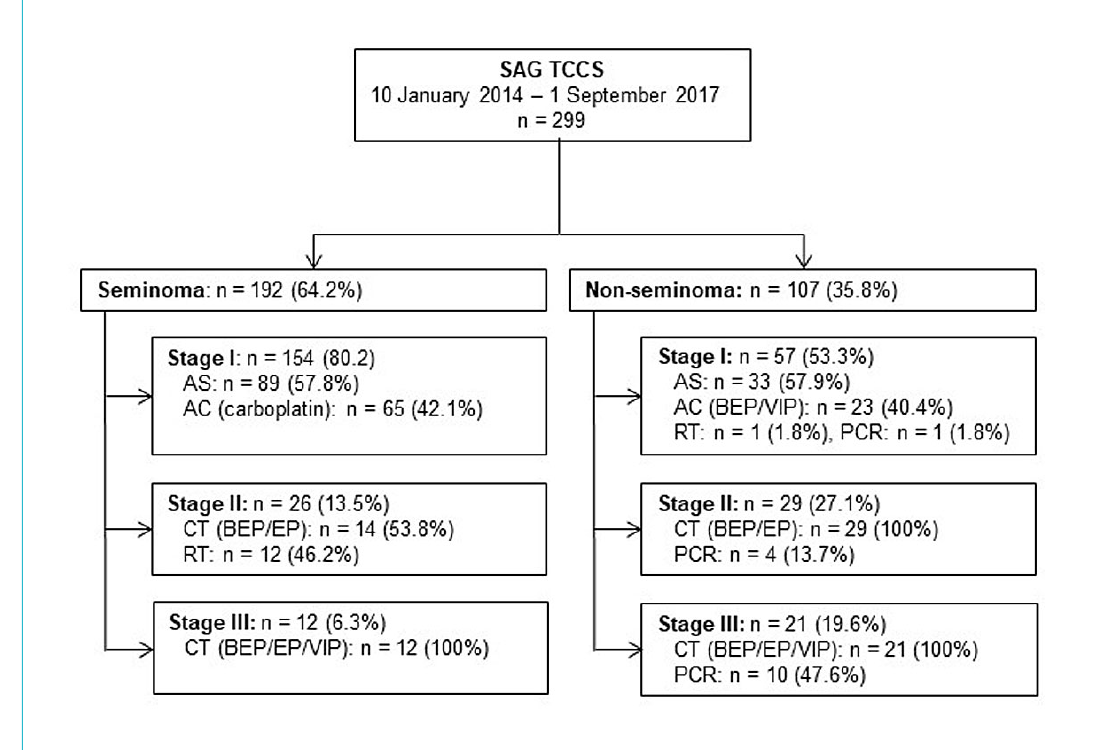
Figure 1: Distribution of GCT patients: AC = adjuvant chemotherapy; AS = active surveillance; BEP = bleomycin, etoposide, cisplatin; CT = curative chemotherapy; EP = etoposide, cisplatin; PCR = postchemotherapy resection; RT = radiotherapy; SAG TCCS = Swiss Austrian Ger- man Testicular Cancer Cohort Study; VIP = etoposide, ifosfamide,